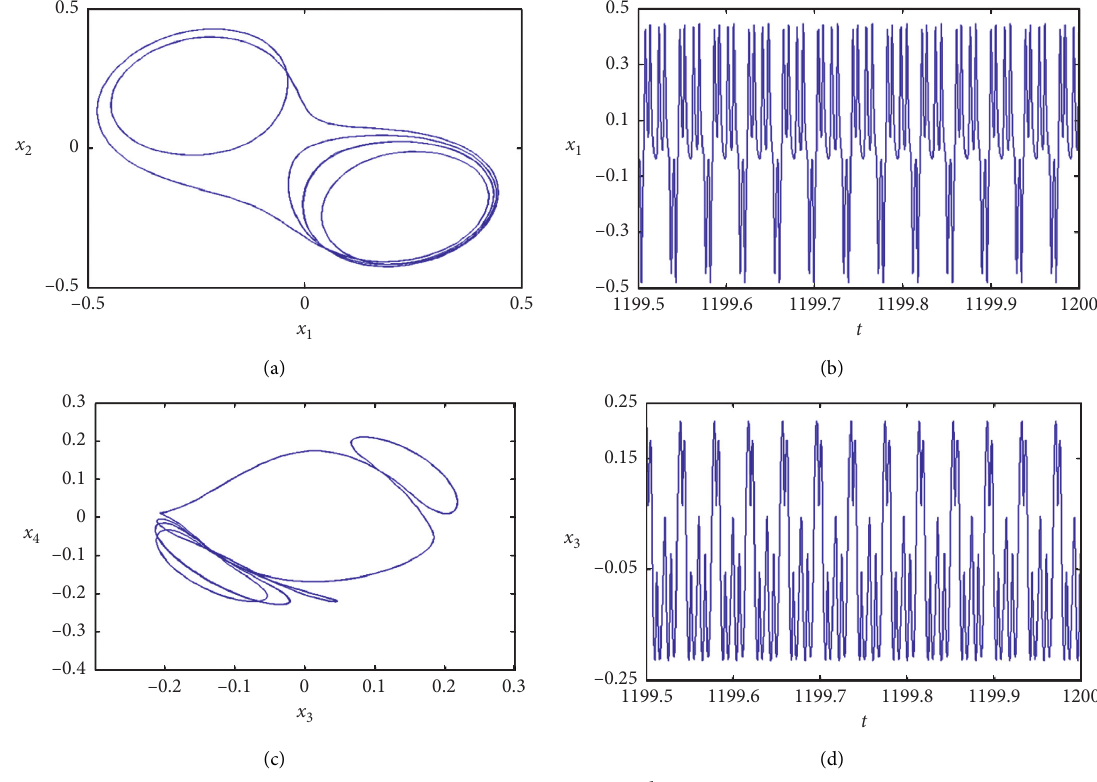
, x ) , (b) waveform on plane ( t, x ) , (c) phase portrait on plane ( x 1 2 1 ,x , x ) , and (g) Poincare map on plane ( x 1 2 3